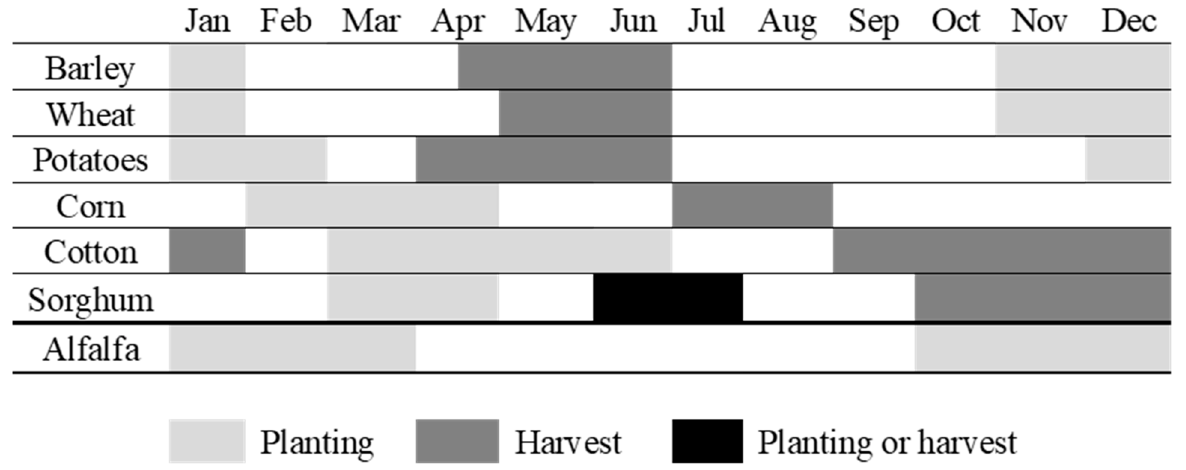
Figure 7. Common planting and harvesting dates for some crops grown in the region (USDA-NASS, 2004).